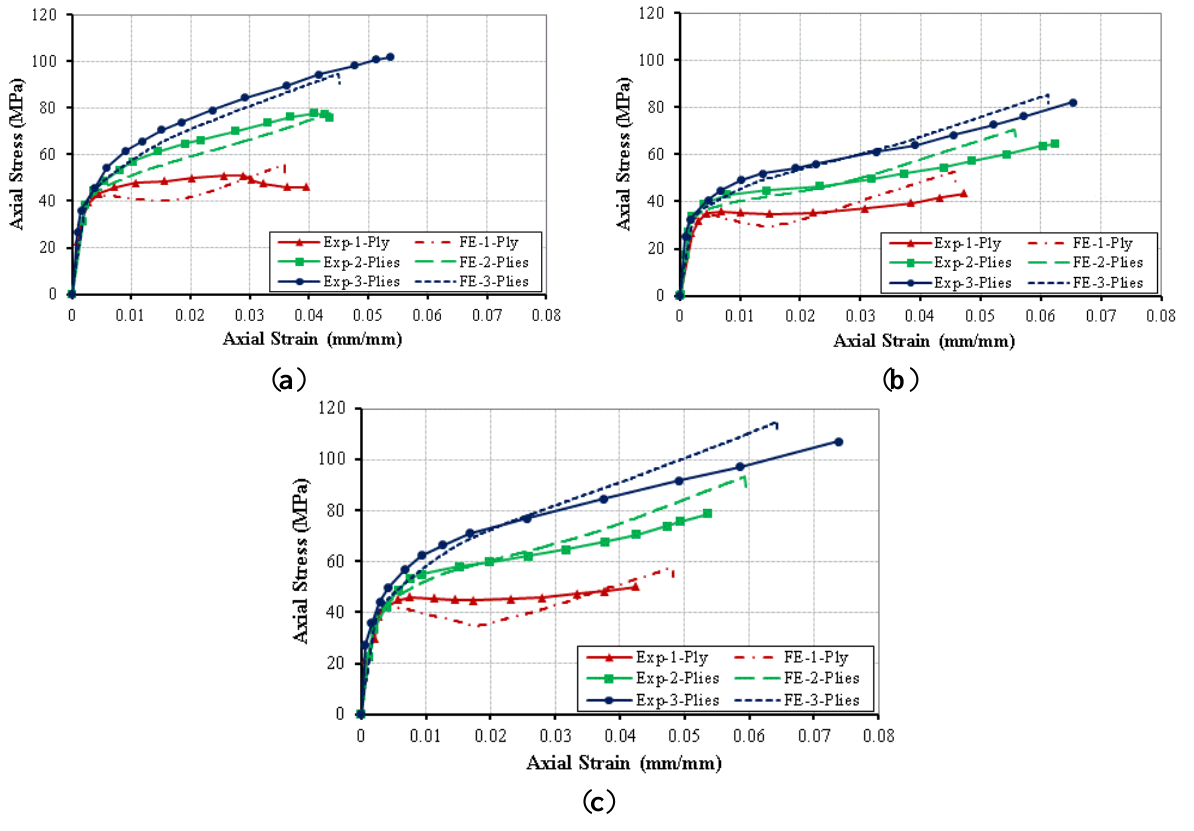
Figure 2. FE results versus experimental results by Dai et al. [13] of the CFFT with: ( a ) PEN-FRP-600; ( b ) PET-FRP-600; and ( c )